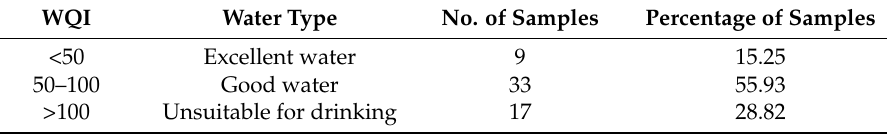
Table 5. Classification of groundwater quality according to the Water Quality Index (WQI).